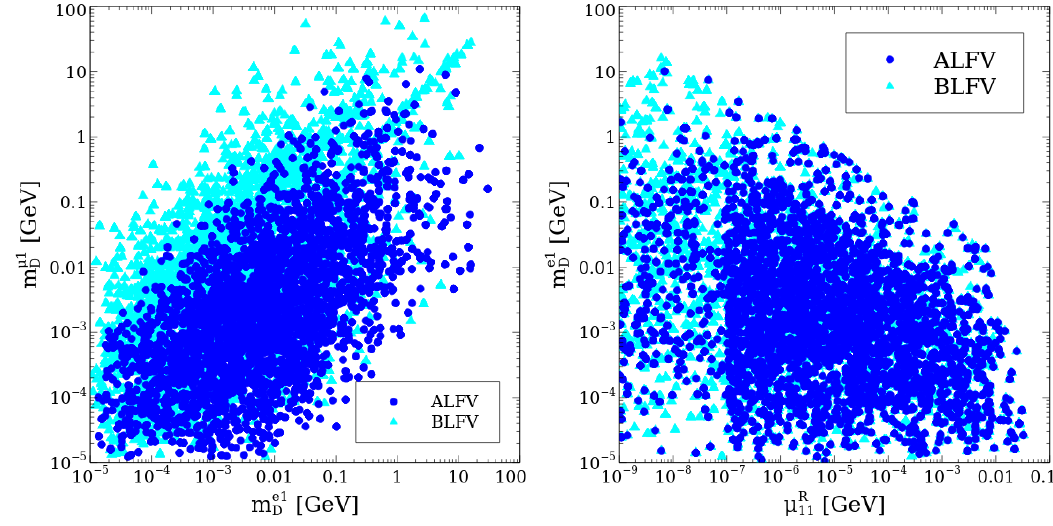
Figure 1 . Allowed parameter spaces after imposing the NOD constraints (cyan) and the NOD constraints plus LFV bounds (blue) are shown in the m e 1 – m e 1 plane in the right panel. ALFV and BLFV respectively correspond to after and before µ R 11 D imposing the LFV bounds.